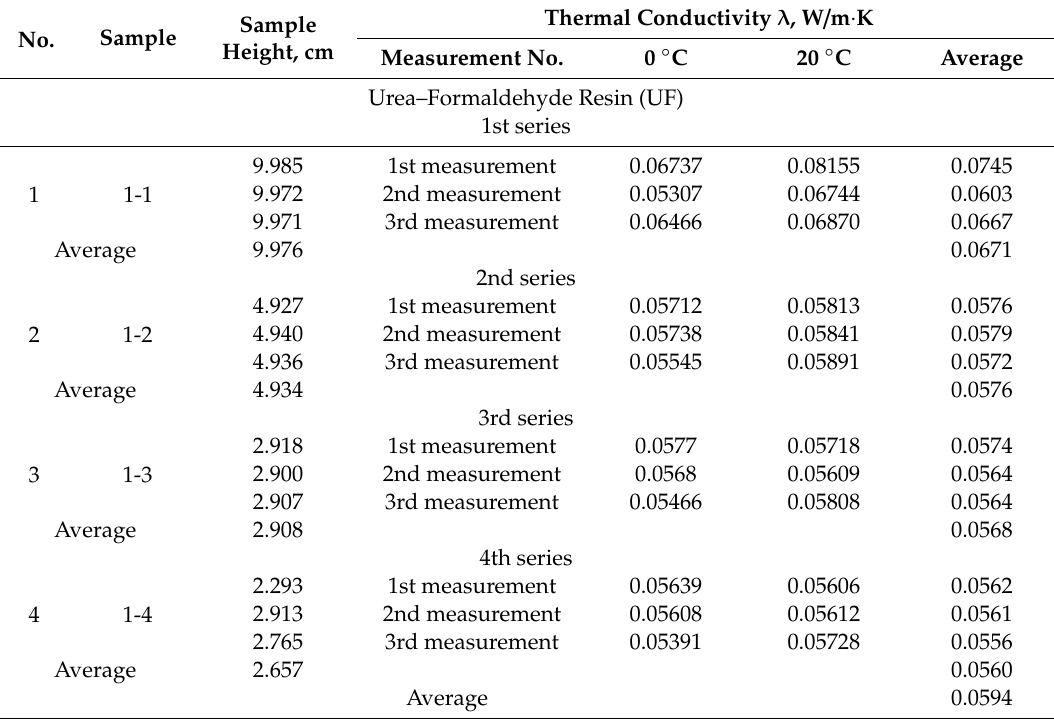
Table 6. Thermal conductivity coe ffi cient of the samples with the urea–formaldehyde (UF) resin glue.